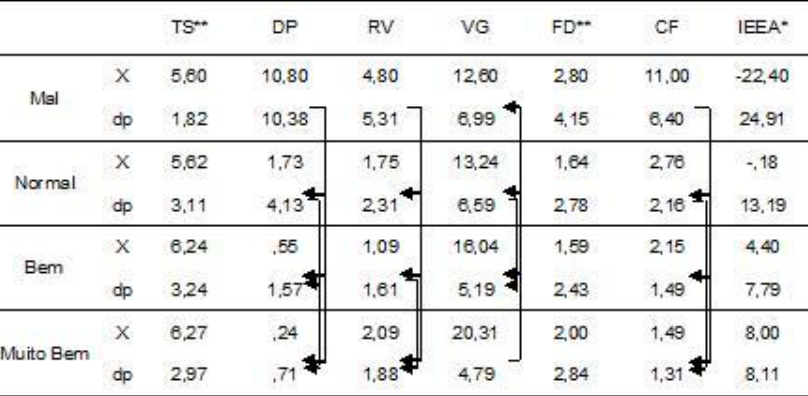
Tabela 6. Valores dos estados de humor para o fator “Como você está na escola com relação as suas notas, tarefas e desempenho?”